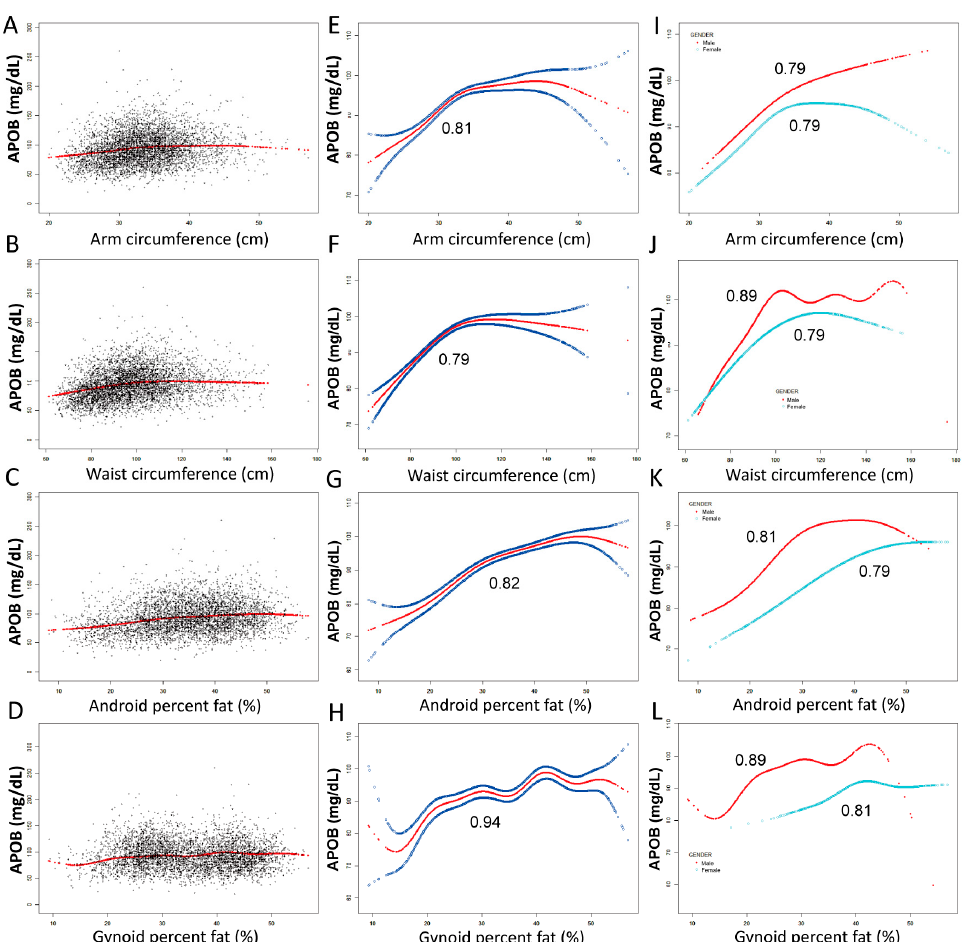
Figure 2. The correlation between ApoB and arm circumference, waist circumference, android percent fat and gynoid percent fat. ( A – D ), black dots indicate the distribution of individual values. ( E – H ), red line shows the smooth curve fitting of the variables, and the area between the two blue lines represents 95% of the confidence interval (CI). ( I – L ), smooth curve fitting of variables stratified by gender (red line for male, blue line for female). Age, gender, race, hypertension, diabetes, hyperlipidemia, coronary heart disease, smoking status and vigorous work activity were adjusted. ( I – L ) were not adjusted by gender.